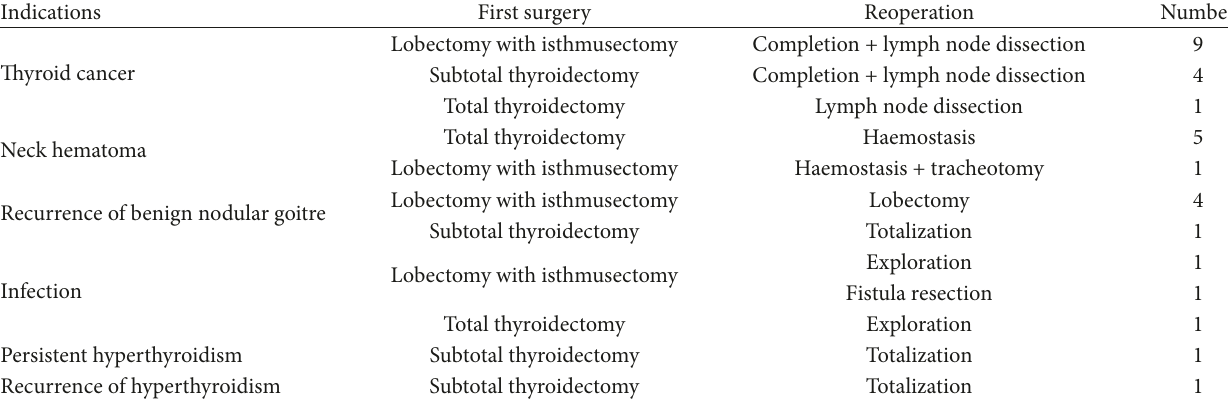
Table 2: Indications of reoperative thyroidectomies with surgical procedure performed at the first surgery and the reoperation.